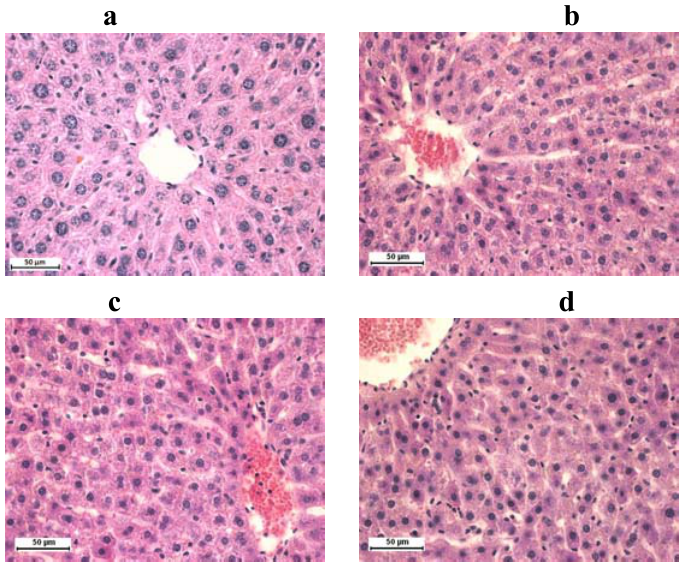
Figure 1. Rat liver stained with H&E technique, 400× magnification: ( a ) control groups; ( b ) group treated with silymarin; ( c ) doxorubicin; ( d ) and combination of doxorubicin and silymarin.